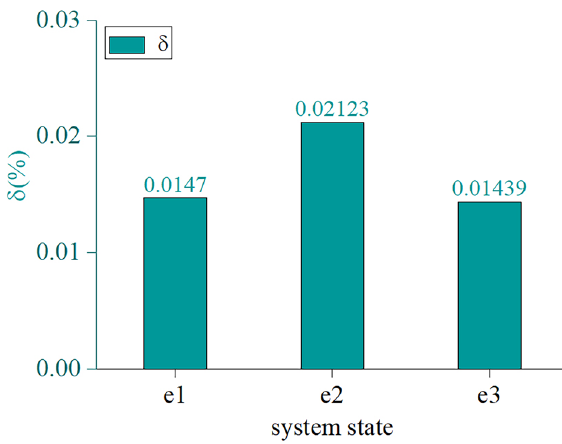
Figure 7. Error between statistical value and analytical